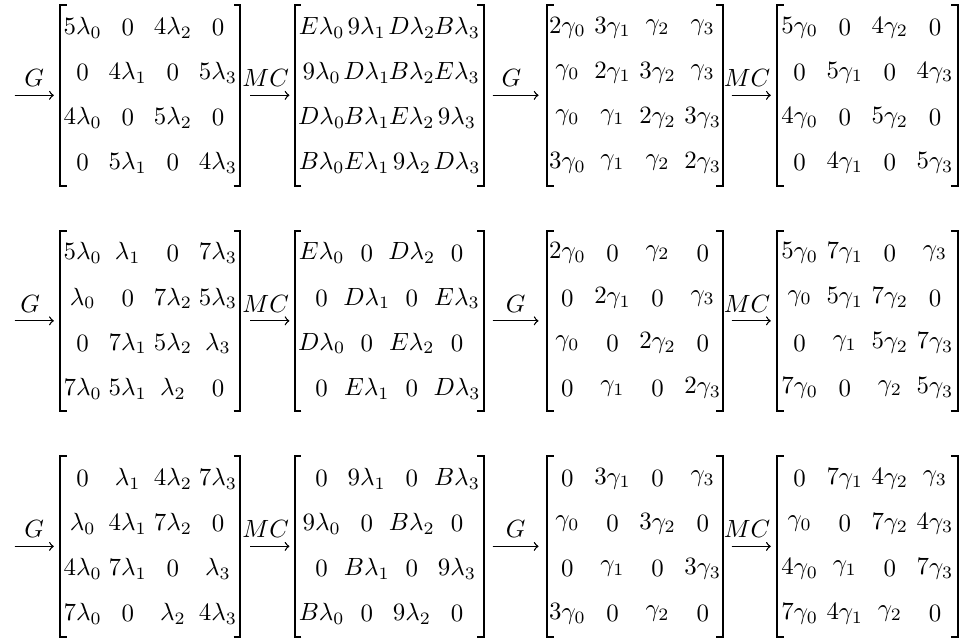
Figure 6: 4-round related differentials trails starting with ∆ x , ∆ x 0 and ∆ x ⊕ ∆ x 0 re- spectively. Differences ∆ x , ∆ x 0 and ∆ x ⊕ ∆ x 0 are not shown here through the lack of